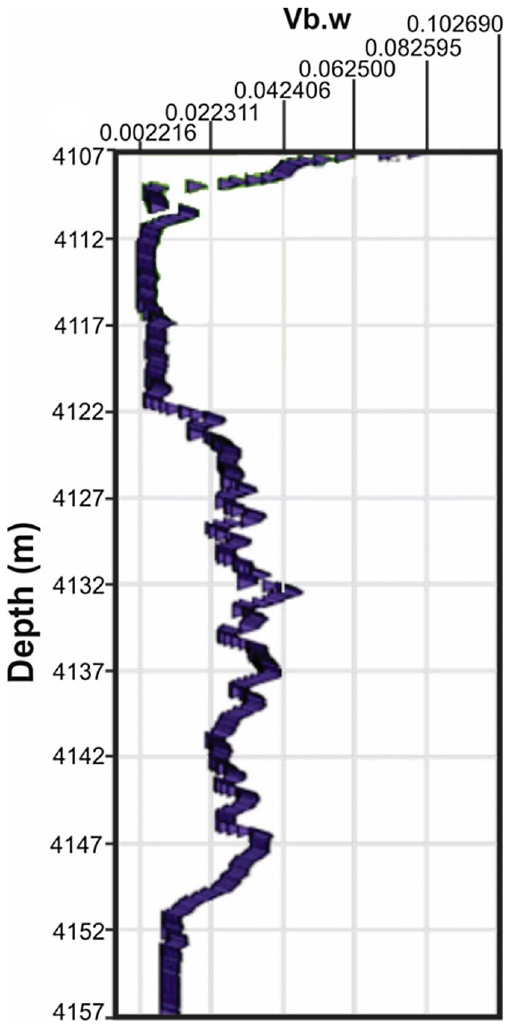
Fig. 10 Cross-plot showing the bulk volume of water (Vb.w) with respect to